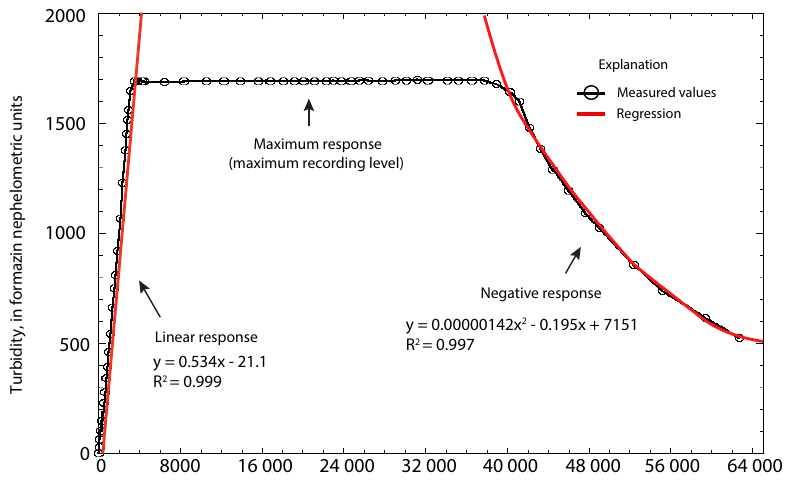
Figure 4. Graph showing the relation between silt-and-clay concentration and turbidity during a laboratory experiment. The silt and clay was obtained from the bank of the Little Colorado River (Fig. 3) and turbidity was measured using a YSI Incorporated model 6136 probe. The fitted curves for the linear and negative response portions of the graph are shown in